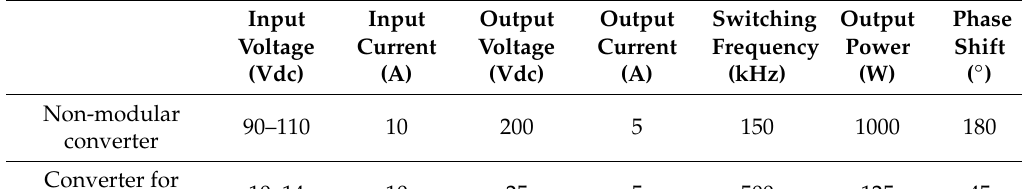
Figure10. Comparisonofqualitativeparametersforthemodularconceptfor1MHzofswitchingfrequency. Figure 10. Comparison of qualitative parameters for the modular concept for 1 MHz of switching frequency.